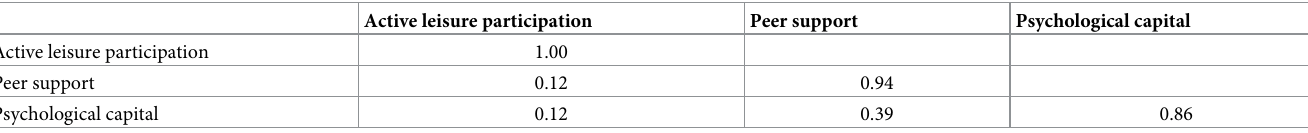
Table 3. Fornell-Larker criterion: The square root of AVE should be higher than other construct’s